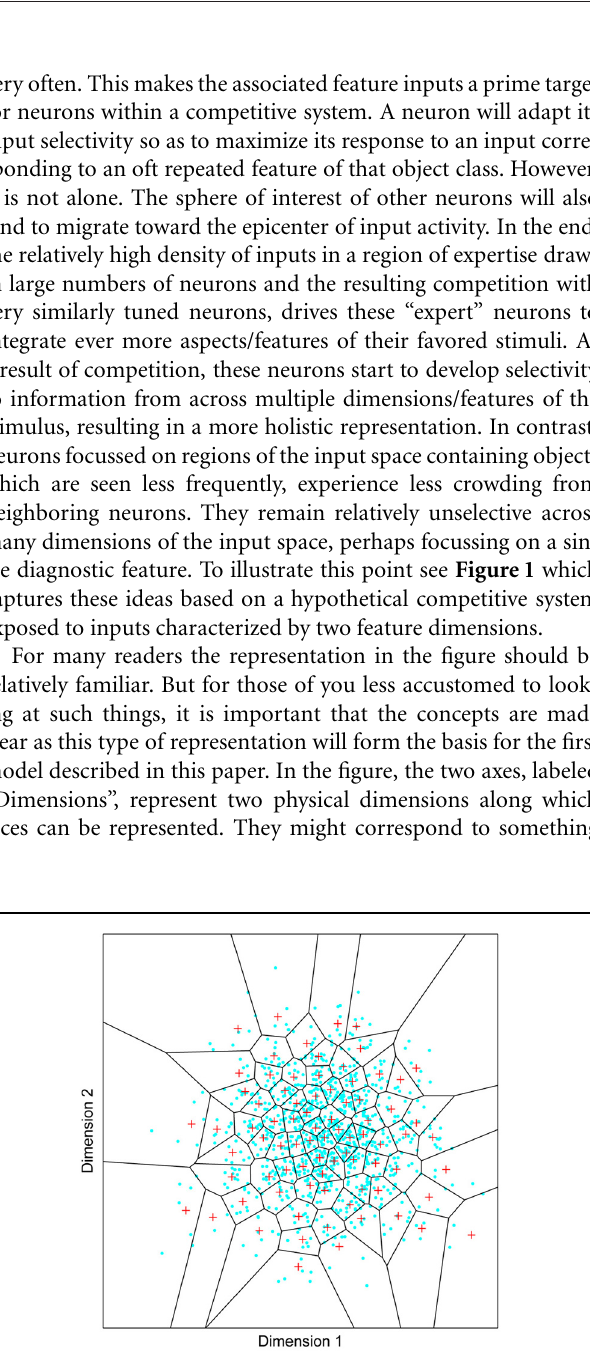
FIGURE 1 | A model of face space in which the physical appearance of a set of 1000 faces is assumed to vary normally along two feature dimensions. Each “Dimension” could correspond to nameable features such as nose width, hair color, eye separation etc., but they might just as well be complex combinations thereof and hence be hard to characterize in words. The red “ + ” points represent the distribution of neural classifiers which emerge from a self-organizing clustering algorithm exposed to the faces. In other words the “ + ” markers indicate the neural weight vector of neurons which serve as the set of abstract-feature classifiers. Light blue dots represent locations of the individual faces and the black lines indicate the boundaries of face space within which the enclosed neural classifier fires most strongly—making this a Voronoi diagram similar to that used by Lewis and Johnston